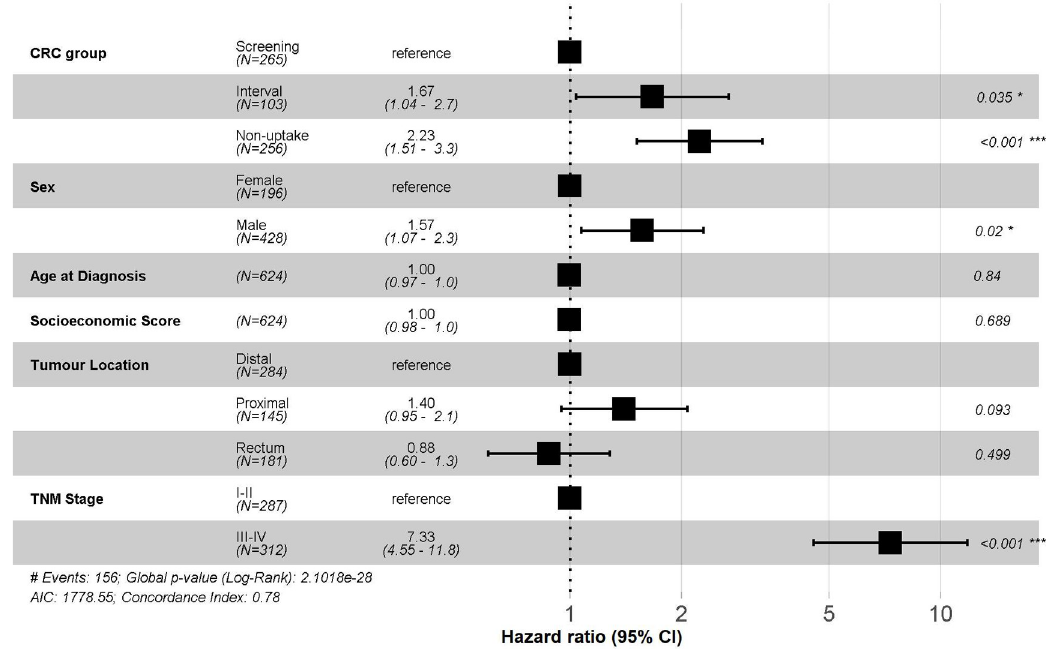
Fig 2. Multivariate analyses for colorectal cancer mortality comparing all the invitee study group. a Hazard ratios adjusted by the variables shown in this figure. CRC: colorectal cancer.